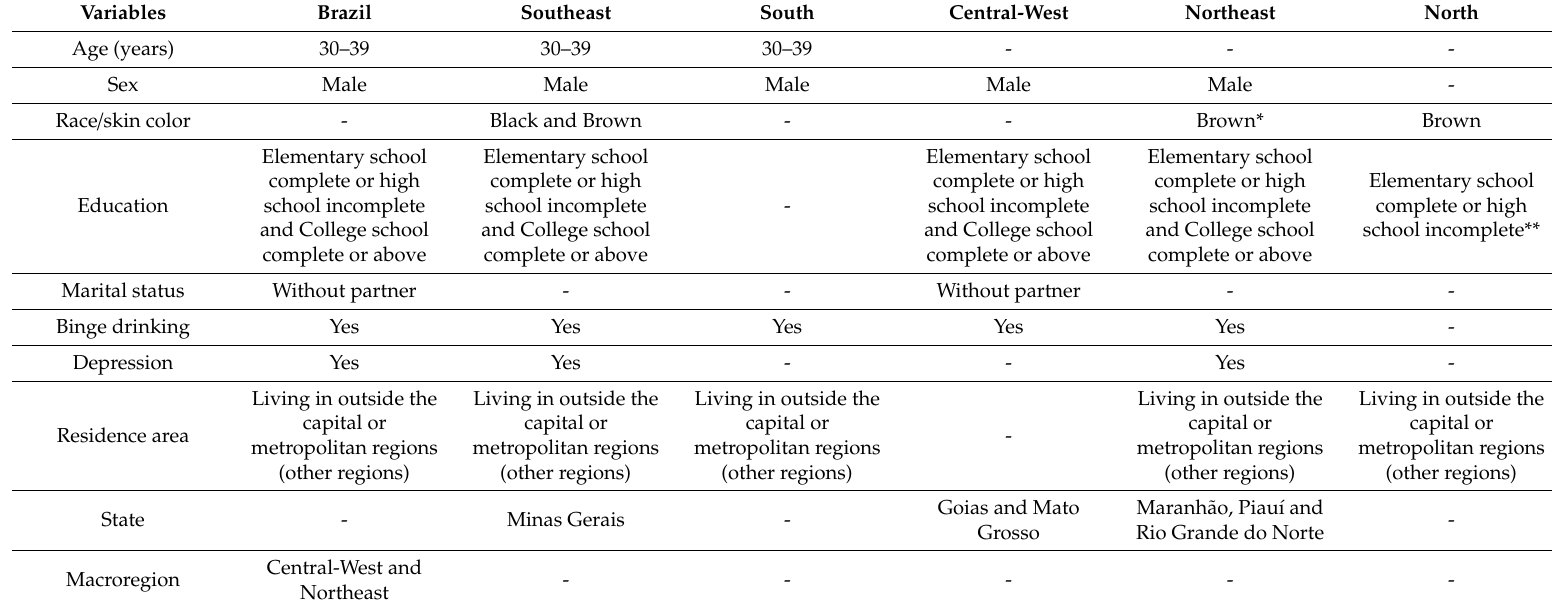
Table 7. Subpopulations and Variables Associated with Driving Under the Influence of Alcohol in Brazil and Macroregions. National Health Survey, 2013.